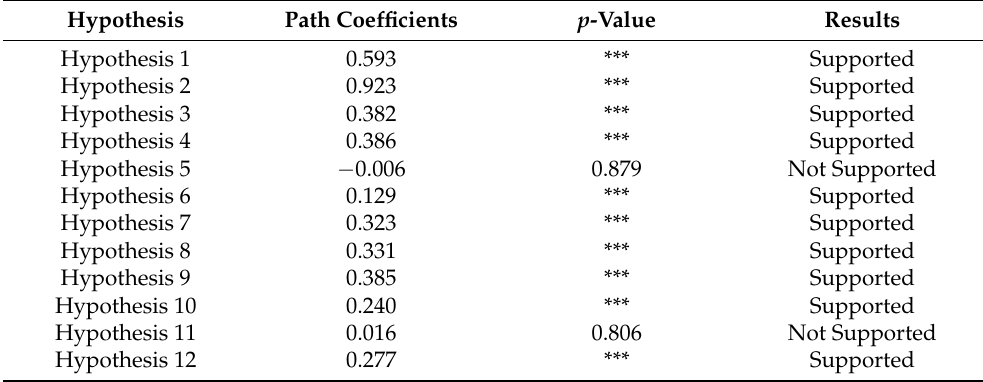
Table 6. Hypothesis